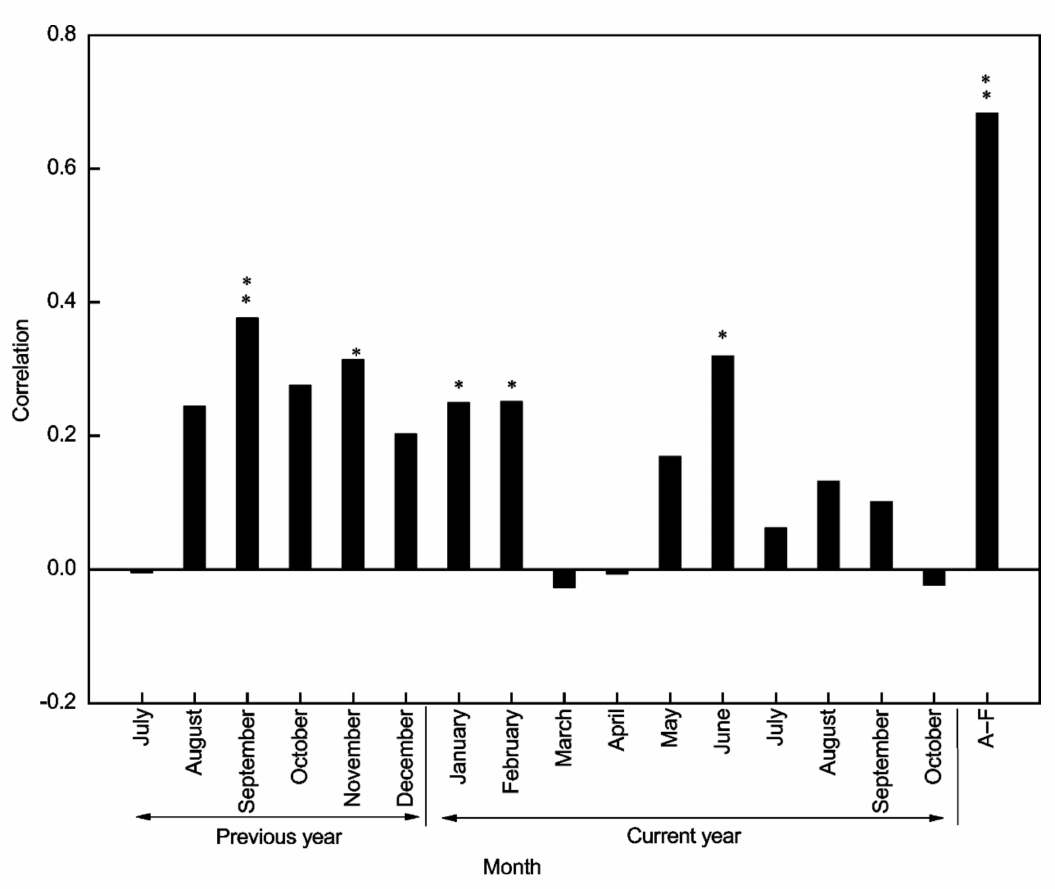
Figure 5. Correlations between the RES chronology and monthly SPEI data (1951–2012 AD). * and ** represent significance at the 95 and 99% confidence limits; A–F: August of the previous year to February of the current